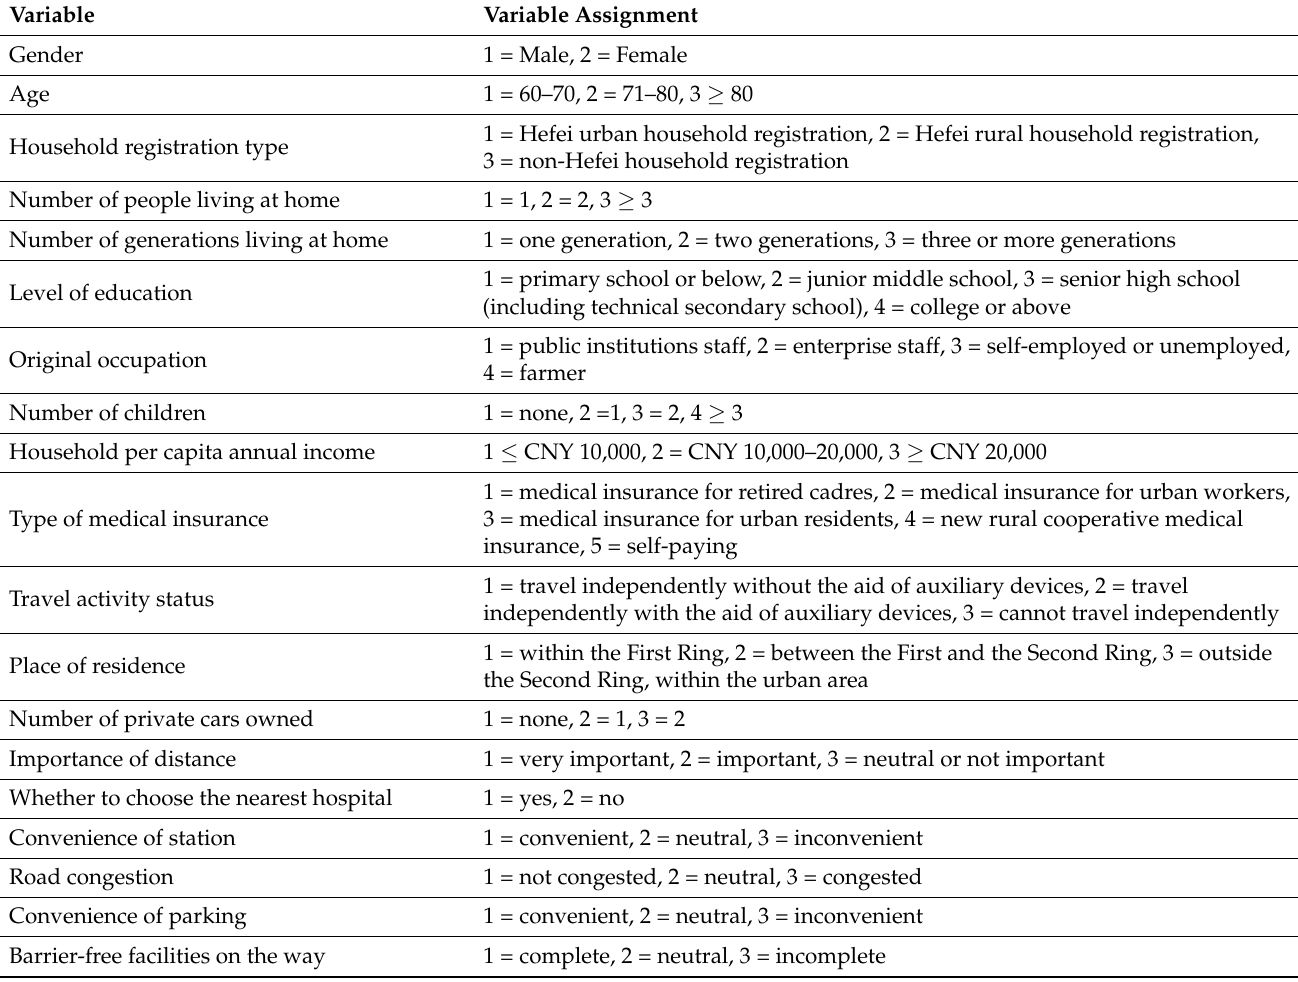
Table A3. Reference for variable assignment in the statistical analysis of this